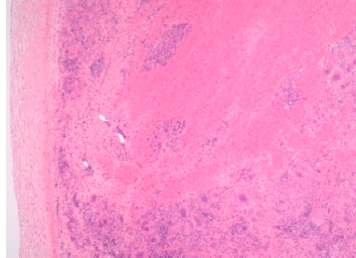
Figure 3. Cardiac sarcoidosis. H&E Magnification 50×.